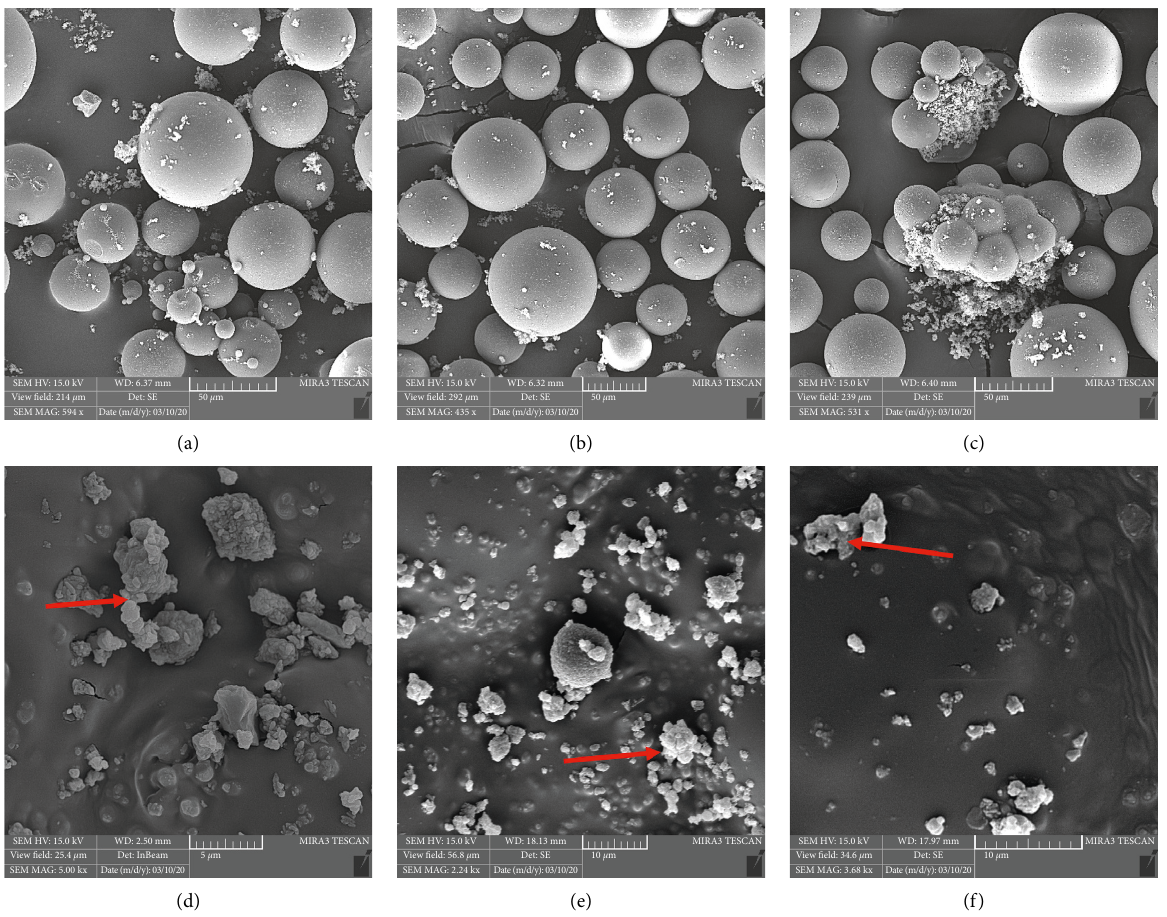
Figure 2: FE-SEM images of acrylic powder containing (a) ZnO/TiO acryl containing (d) ZnO/TiO 2 /4A, (e) TiO 2 /4A, and (f) ZnO/4A. Accumulation of 4A zeolites observed in some areas indicated by red